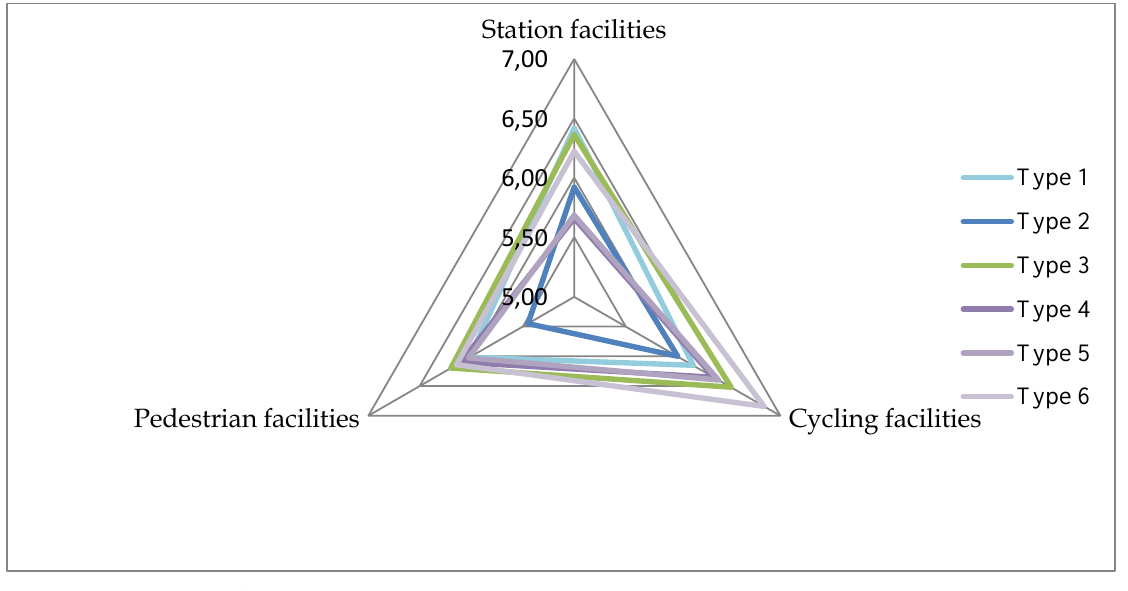
Figure 2. Assessment by station type  Design of bicycle